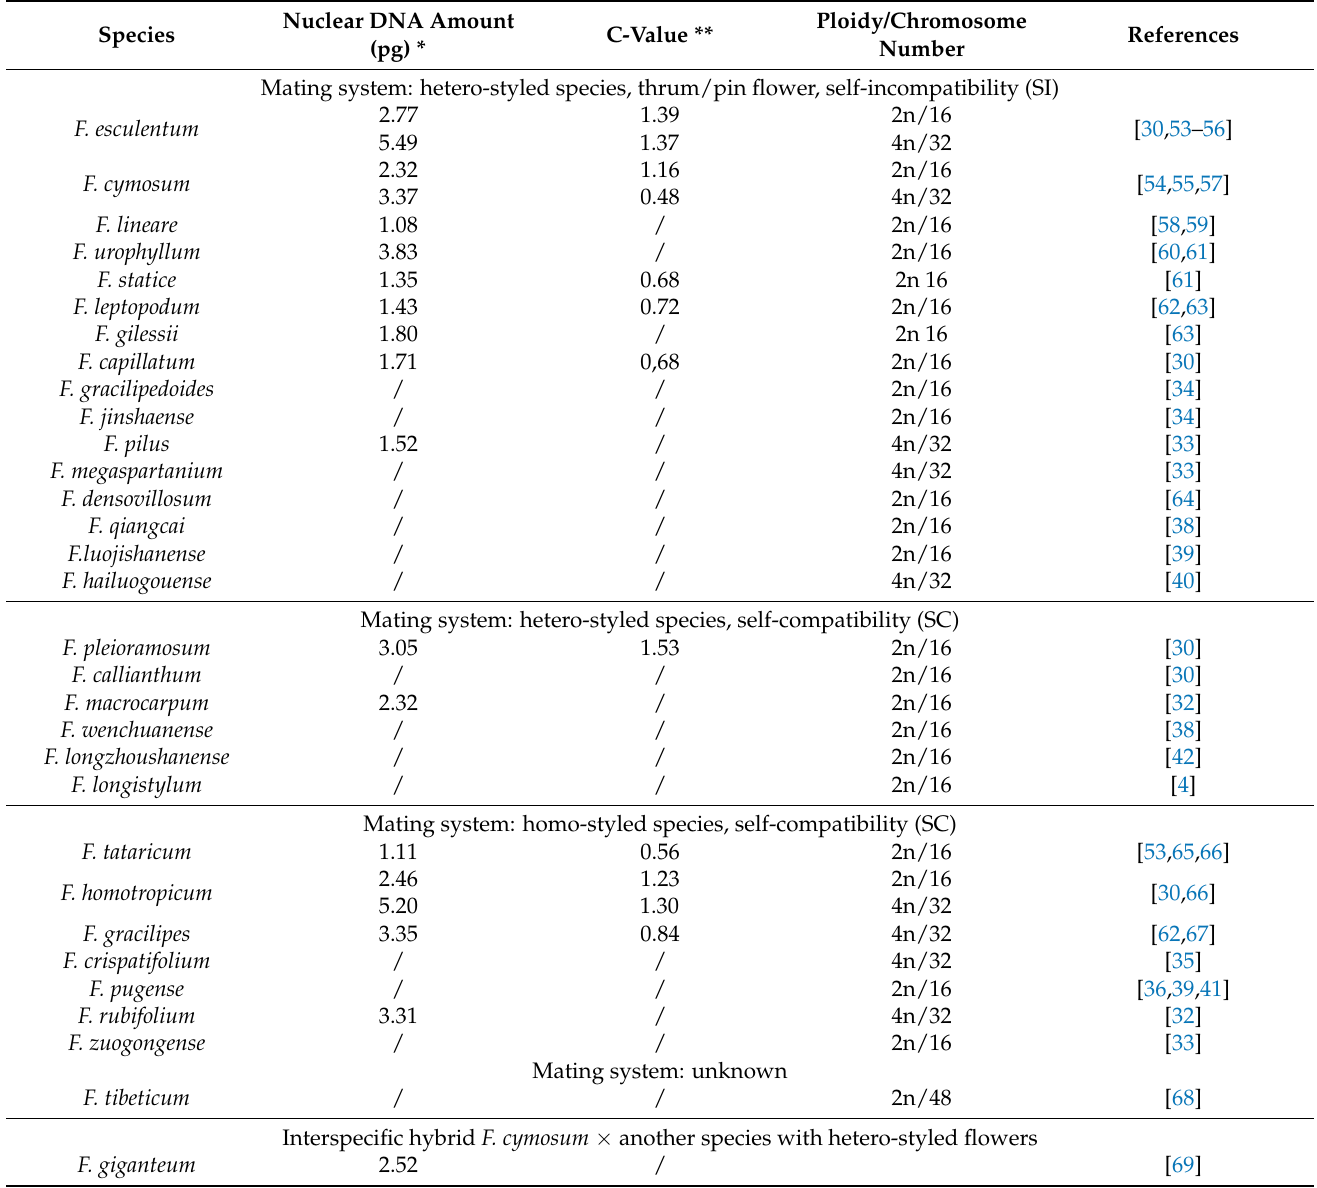
Table 1. Fagopyrum species: hetero-styled self-incompatibility (SI), hetero-styled, self-compatibility (SC) and homo-styled self-compatibility (SC), ploidy level and genome